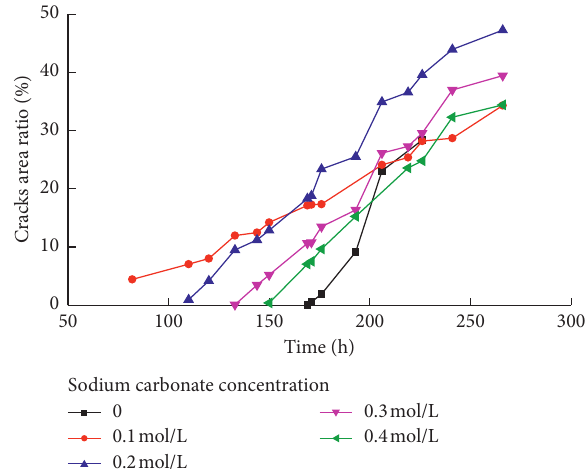
Figure 3: The curves of area-fissure rate and time of soil con- taminated by sodium carbonate.